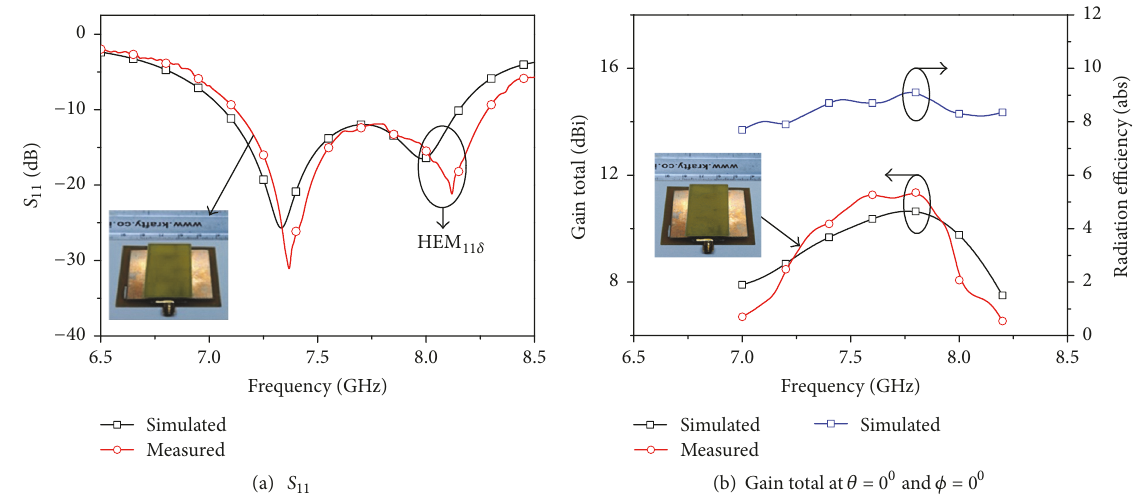
Figure 14: Comparison of simulated and measured results of Antenna